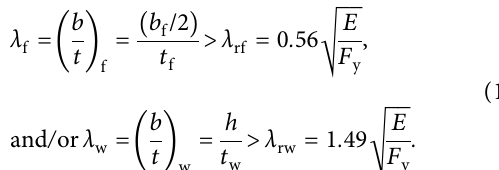
Table 1: European steel sections examined in the study and nominal values of yield strengths (in N/mm 2 ) for different steel grades. Section Section number HEA, HEB, and HEM